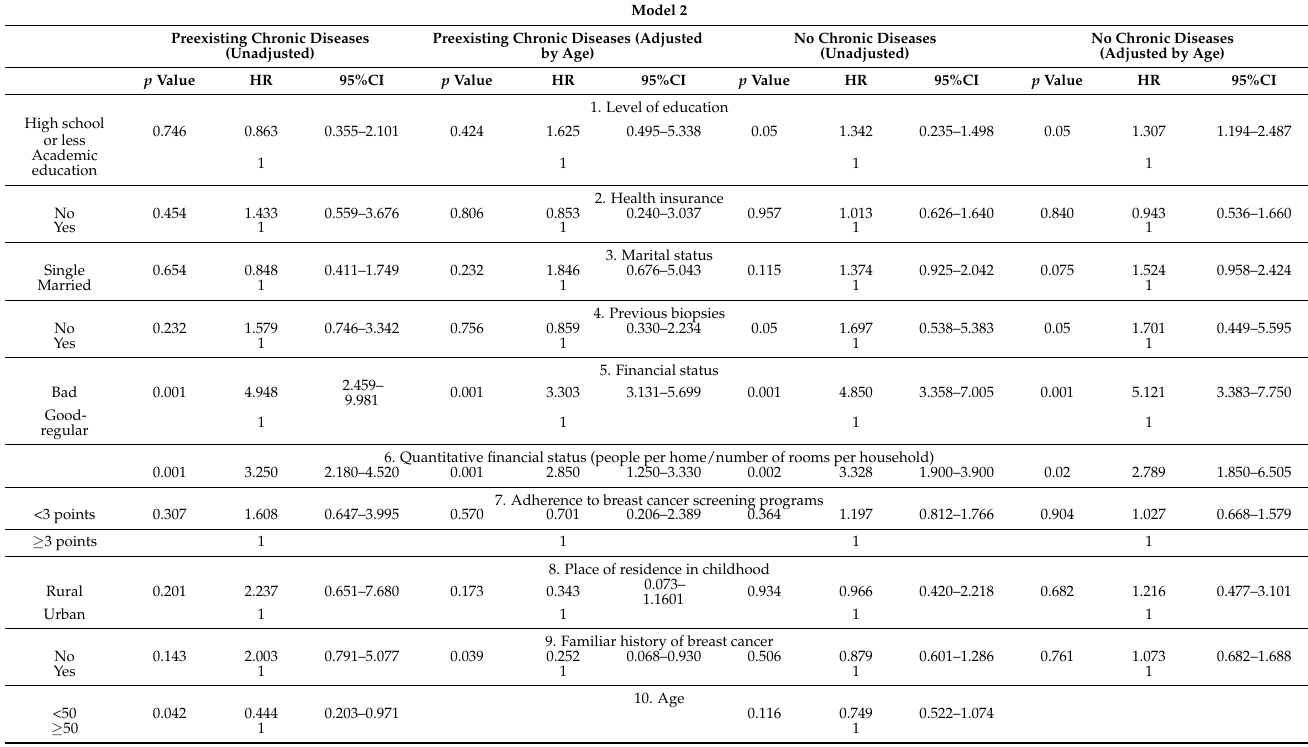
Table 4. Multivariate cox regression model of breast cancer–specific survival, stratifying by preexist- ing chronic diseases other than cancer.